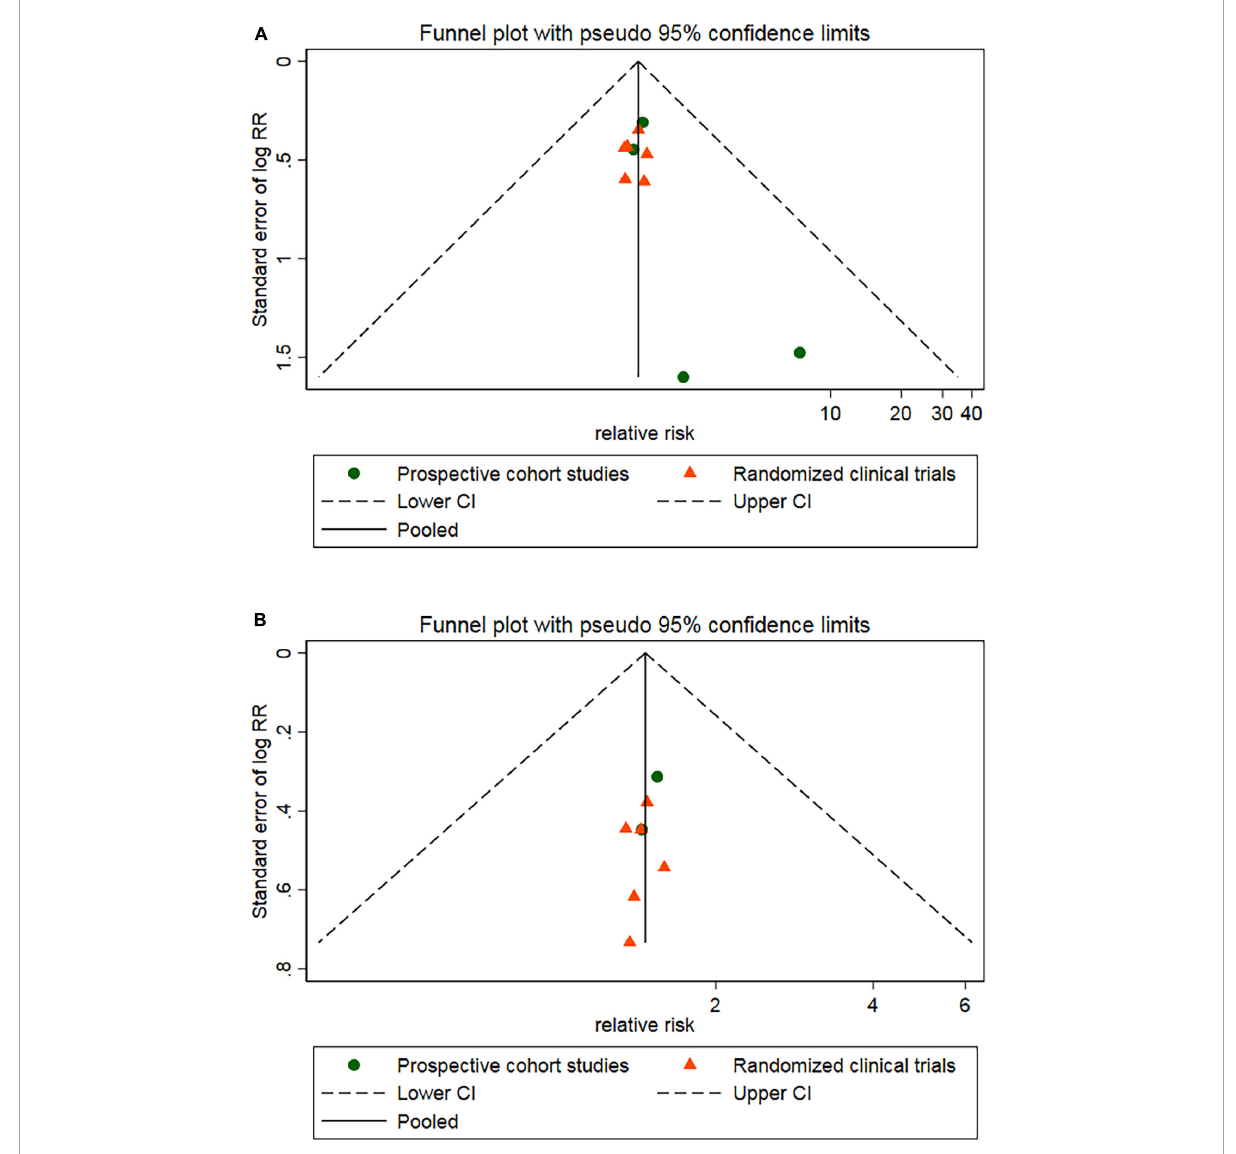
FIGURE4 Egger’s funnel plot indicated low level of heterogeneity for evaluating MACEs (A) and rehospitalization (B) . MACE, major adverse cardiac event; RR, relative risk; CI, confidence interval.